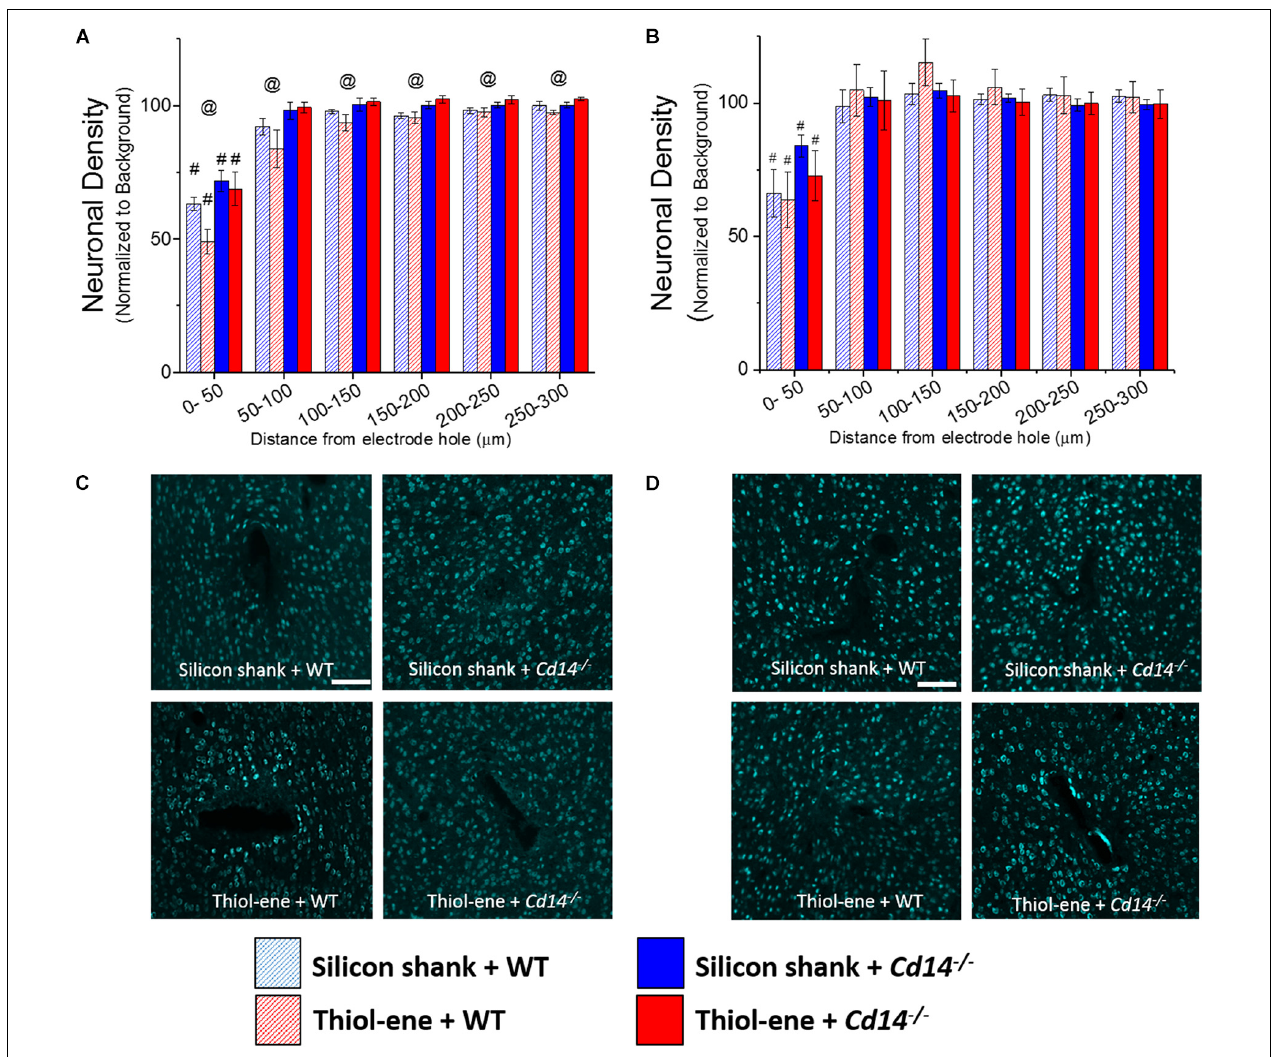
FIGURE 2 | Immunohistochemical evaluation of neuronal density. Neuronal density evaluated as NeuN + cells with respect to distance from the explanted microelectrode hole ( µ m). (A) 2 weeks. (B) 16 weeks. (C) Representative images of 2 weeks neuronal density. (D) Representative images of 16 weeks neuronal density. Scale bar: 100 µ m. @ Denotes significance between WT and Cd14 − / − ; # denotes significant difference from background neuronal